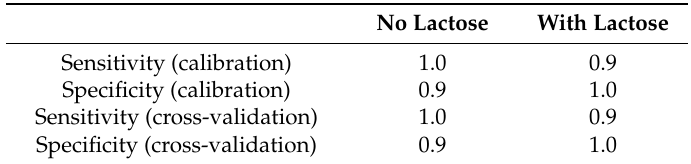
Table 4. PLS-DA results for the presence or absence of lactose using the SCiO data. No